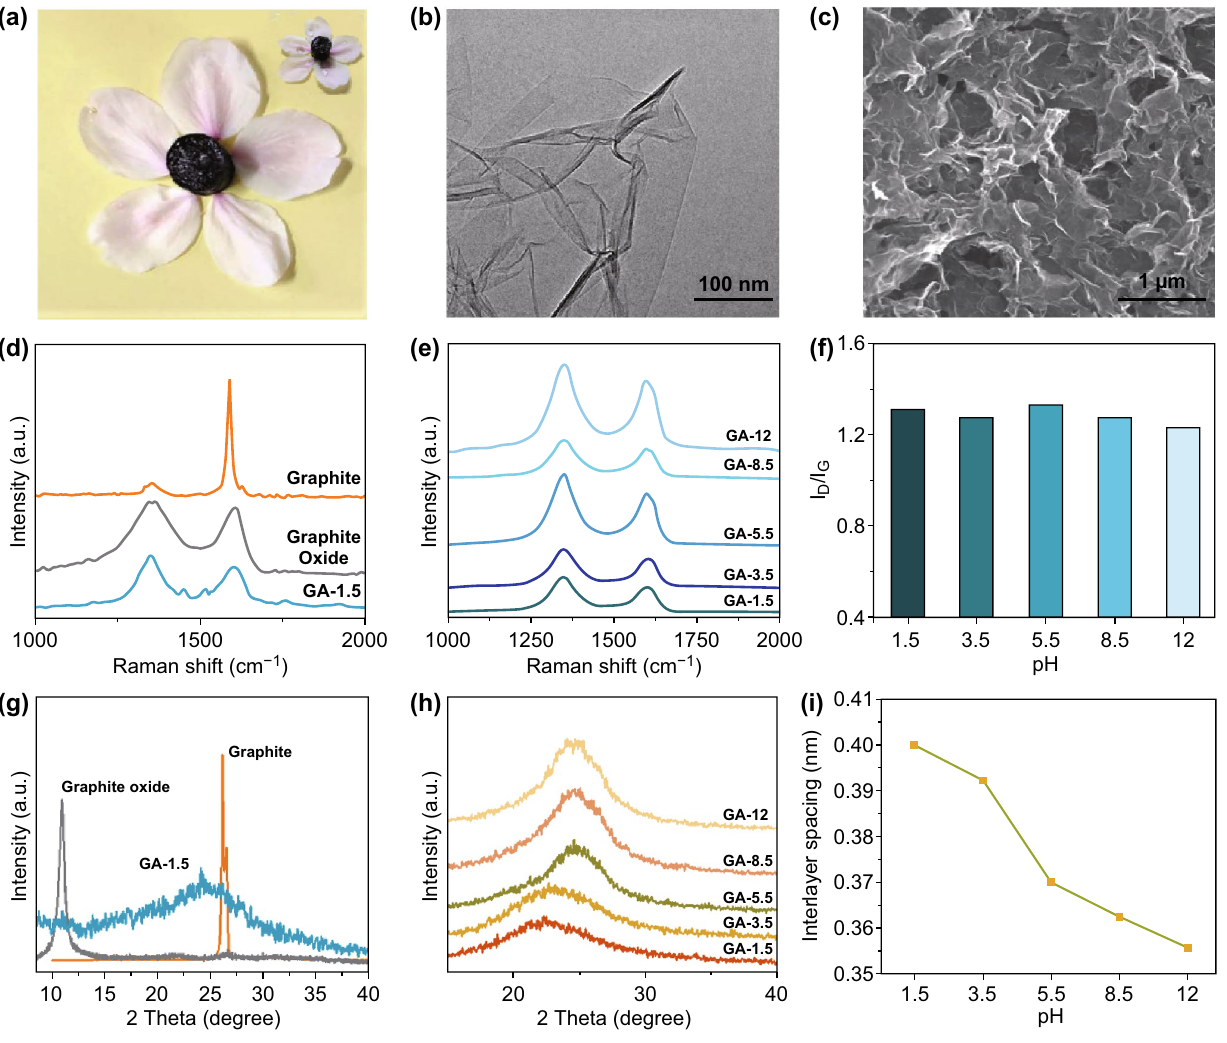
Fig. 1 a Optical image of GH. b TEM, and c SEM images of GA; d Raman spectra of graphite oxide, graphene oxide (GO) and GA-1.5, e Raman spectra of the GA samples under different pH; f I D / I G values for the GA samples; XRD patterns of g graphite, graphite oxide, GA-1.5, and h the GA samples; i the calculated interlayer spacing values for GA samples under different